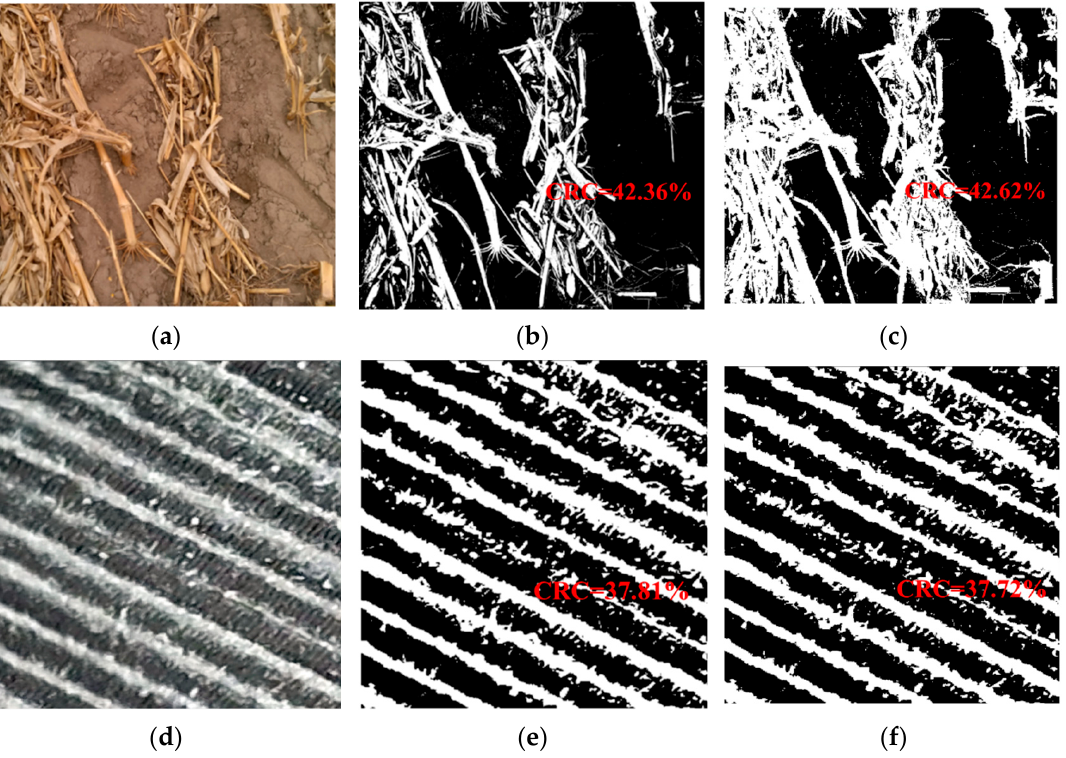
Figure 6. Examples of collected CRC samples using the OSTU method from photos taken in field campaign ( a – c ) and high-resolution images collected from Google Earth ( d – f ).